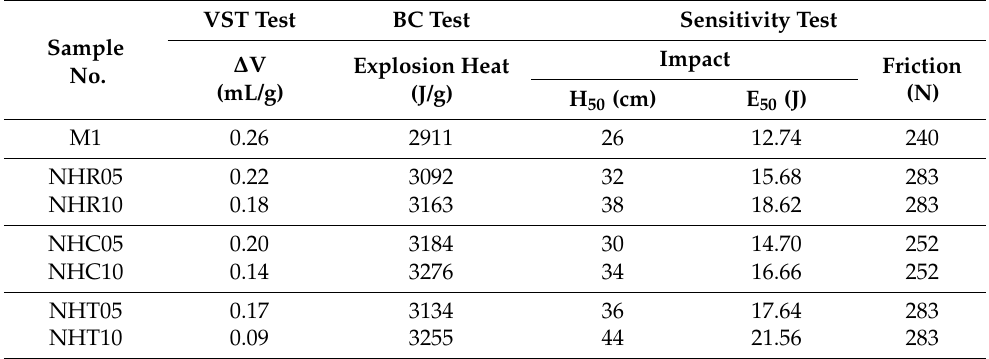
Figure 6. Pressure–time curves of reference sample M1 and three series of NC/HTPB-based high- Figure 6. Pressure – time curves of reference sample M1 and three series of NC/HTPB-based high- energy gun propellant samples obtained by VST with 100 ◦ C/40 h. energy gun propellant samples obtained by VST with 100 °C/40 h. Table 3. Experimental results of VST, BC and sensitivity Table 3. Experimental results of VST, BC and sensitivity tests.